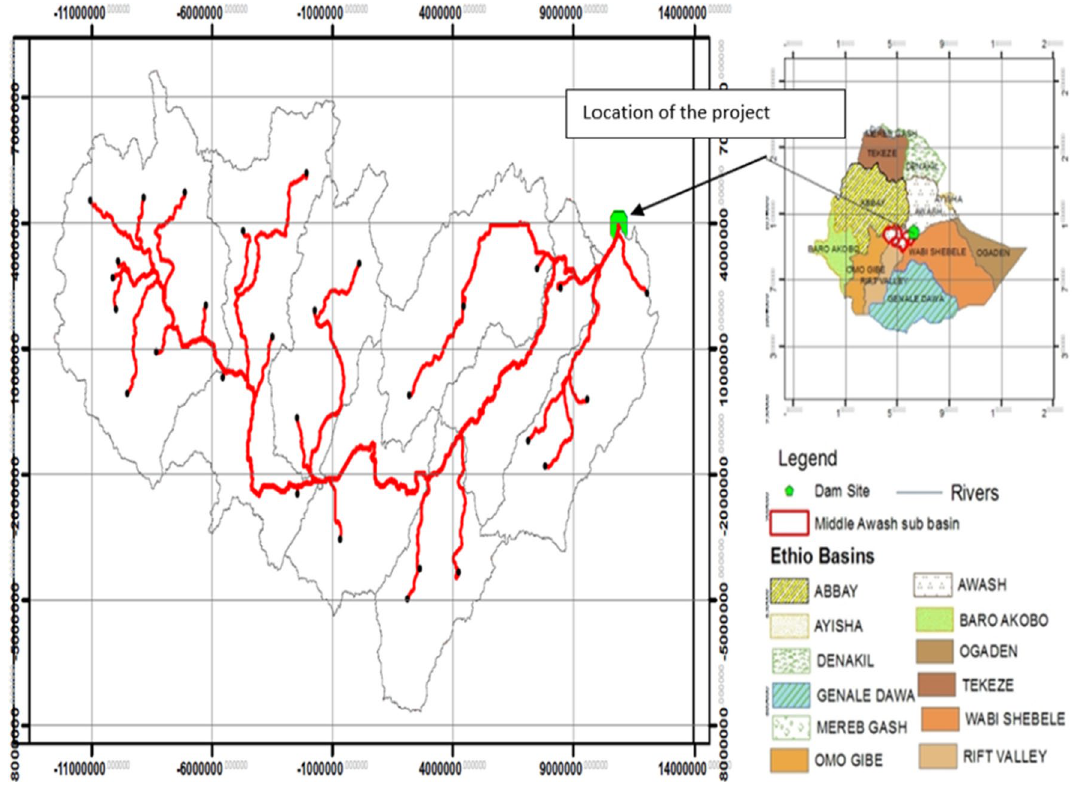
Fig. 1 Location of catchment area of Middle Awash multi-purpose